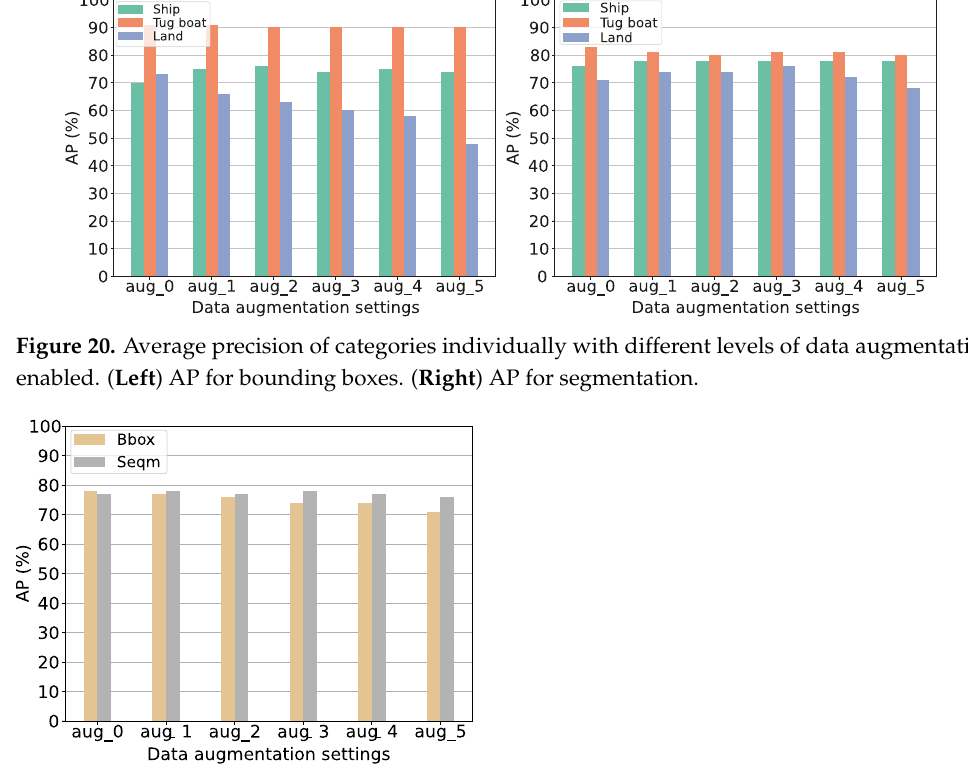
Figure 21. mAP with different levels of data augmentation